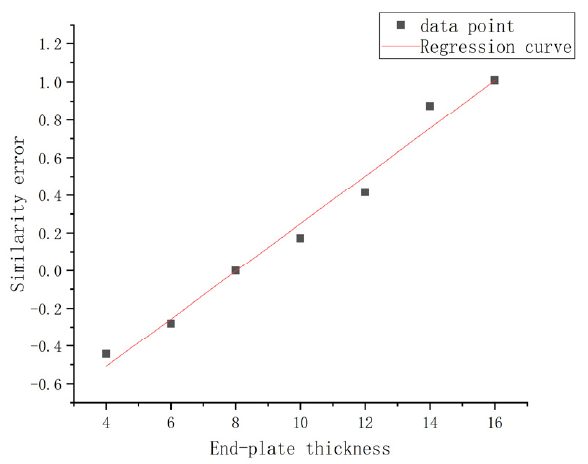
Figure 26. Data points and the regression curve at C f .